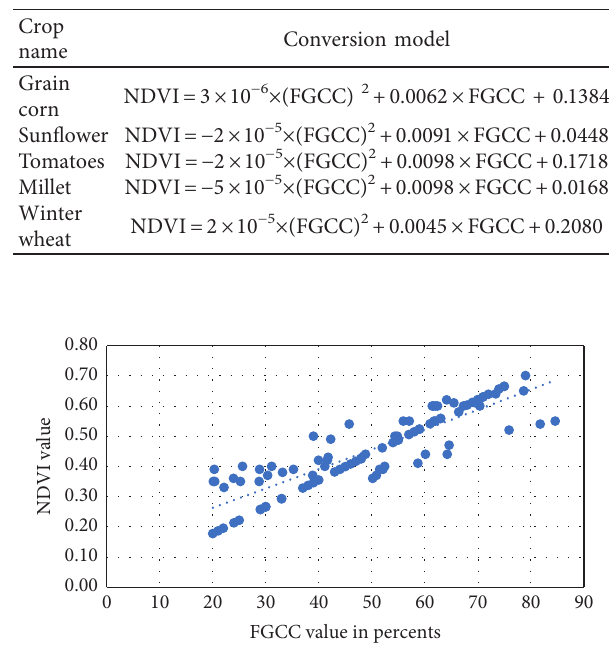
Figure 1: Approximation of the polynomial model for FGCC into NDVI conversion for grain corn.